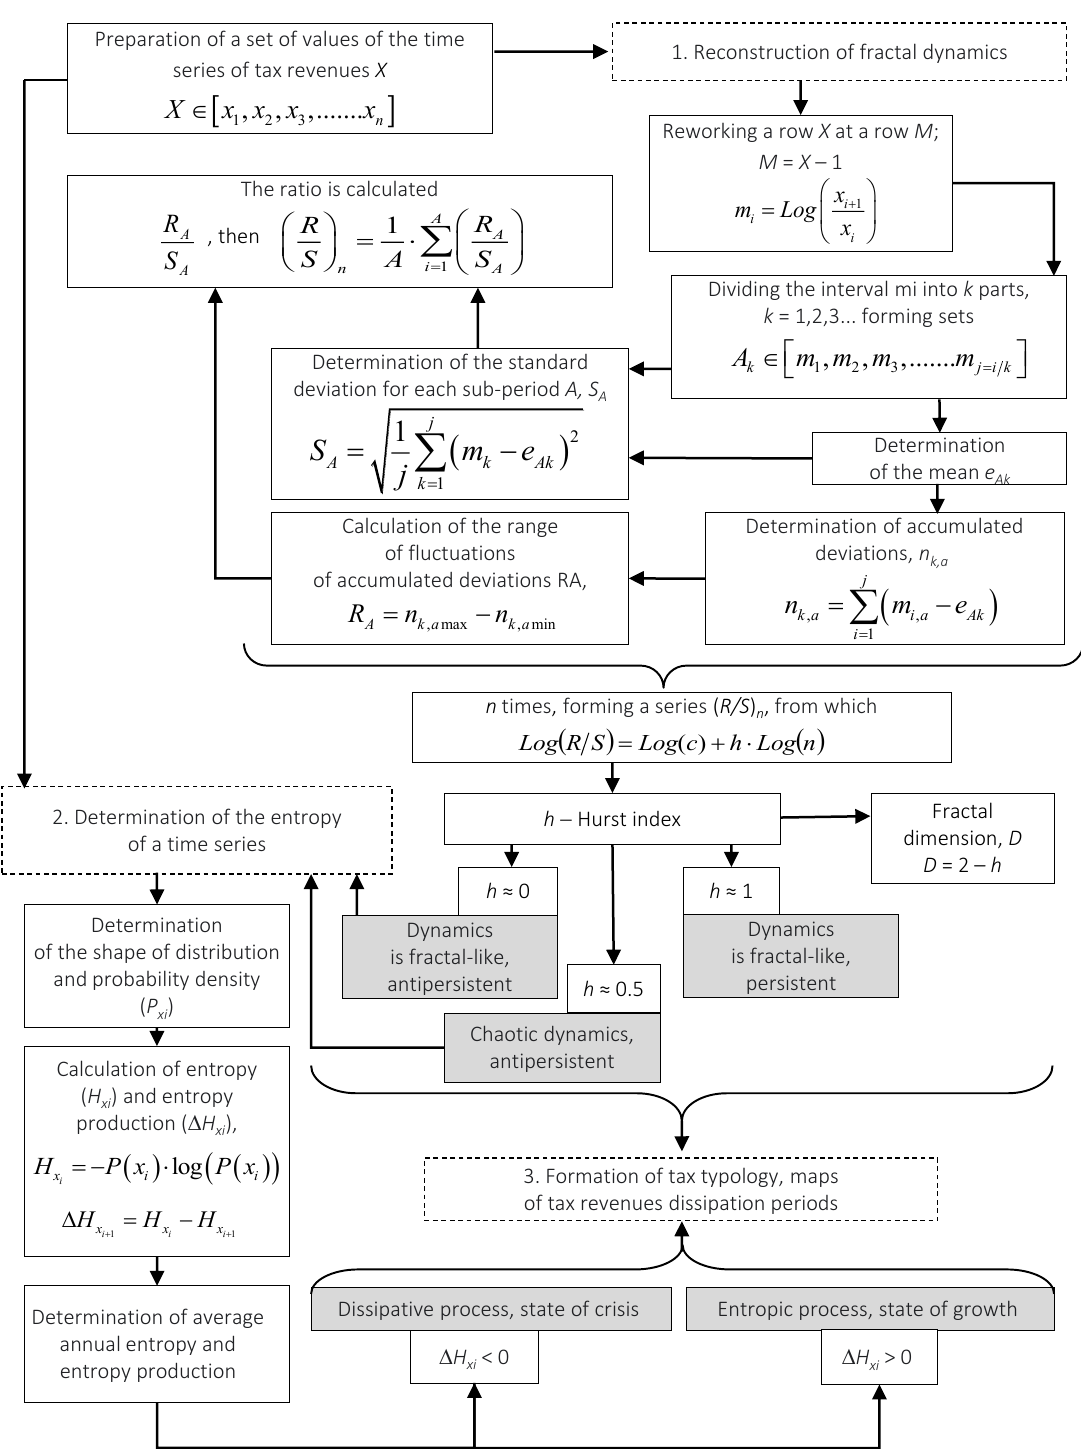
Figure 1. Sequence of forecasting the volume of tax revenues during the crisis